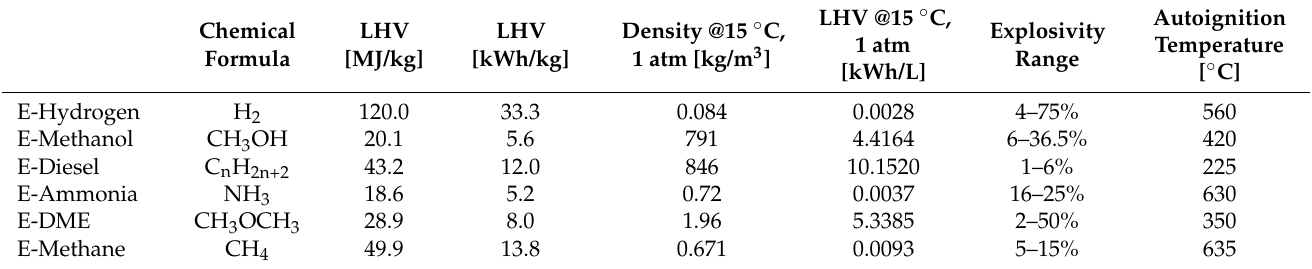
Table 6. E-fuel main properties. Data from[52 – 54] .